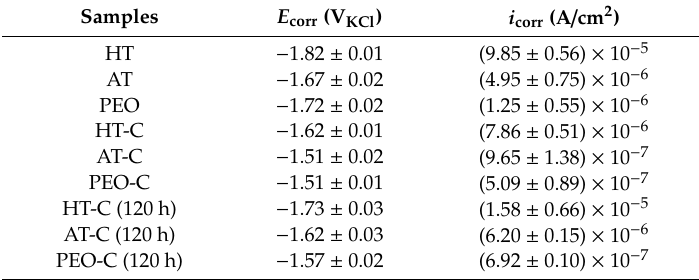
Table 3. Electrochemical data of the samples as fitted by extrapolation from potentiodynamic polarization curves.